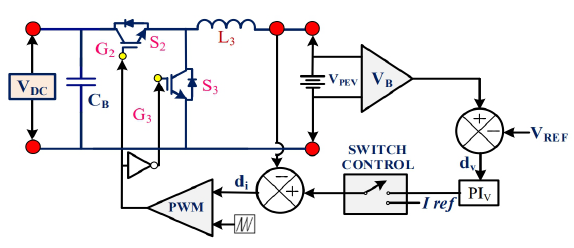
Fig. 3. Bidirectional Converter Constant current (CC) and Constant voltage (CV) control mechanisms for charging PEV battery.